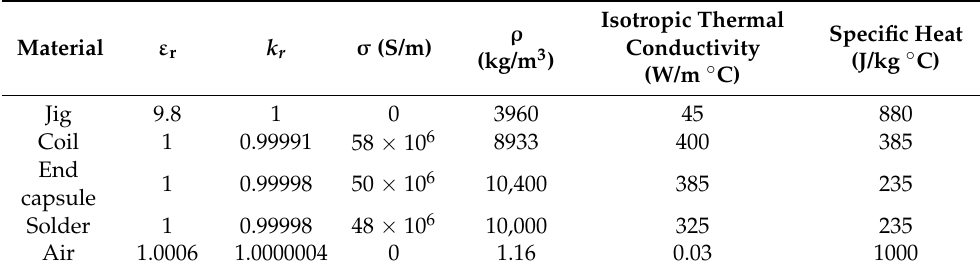
Figure 10. Boundary conditions for multiphysics settings: ( a ) an overview and ( b ) on the product. Table 1. Material properties (data from refs. [26,27] and the manufacturer at room temperature of 25 °C).